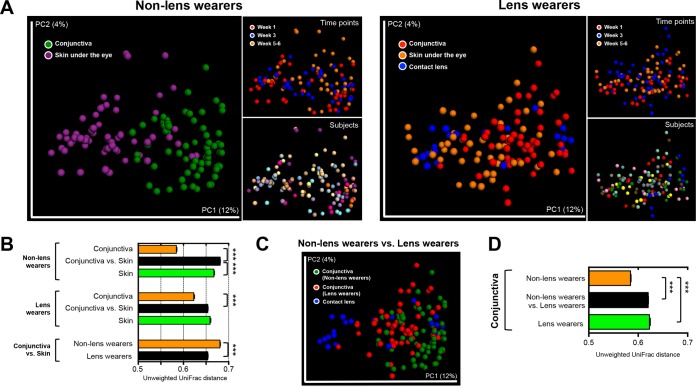
Beta diversity in conjunctiva, skin, and contact lens samples between non-lens wearers and lens wearers. Unweighted UniFrac distances were used to evaluate diversities between samples. (A) PCoA plot of bacterial communities by body site, time, and subject in non-lens wearers (left) and lens wearers (right). PC1, first principal component; PC2, second principal component. (B) Box plots of intragroup and intergroup distances in bacterial communities between conjunctiva and skin under the eye. (C) PCoA plot of ocular microbiota in non-lens wearers and lens wearers with bacterial communities of contact lenses. (D) Box plots of intragroup and intergroup distances in the ocular microbiota of non-lens wearers and lens wearers. ***, P value = <0.001.